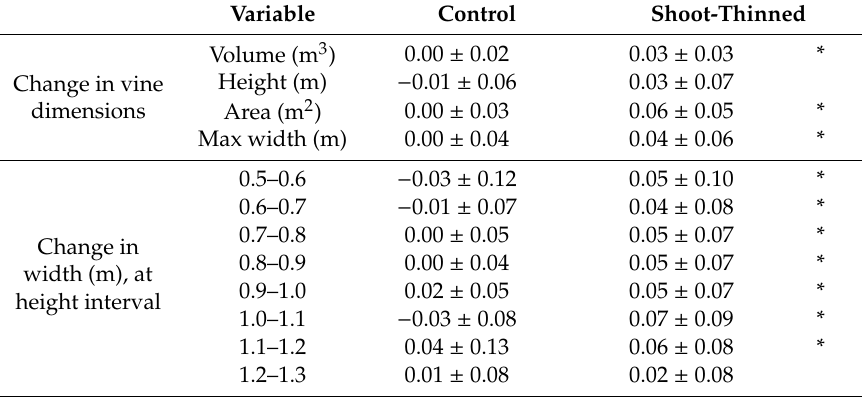
Table 3. Mean and standard deviation of vine dimension changes after the shoot thinning experiment at Azagra. The table is divided in two parts: (1) changes in main dimensions of the vine, (2) changes in the width at di ff erent height intervals. Values followed by an asterisk are indicative of significant di ff erences among the vine dimensions before and after the canopy management (paired T -test at p = 0.05).